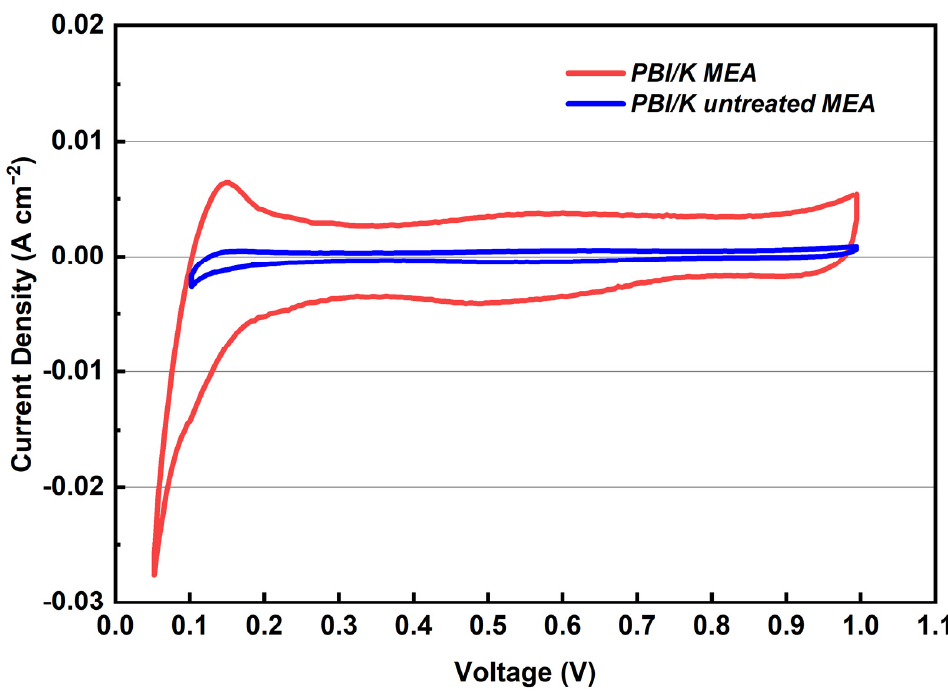
Figure 7. Cyclic voltammograms of treated and untreated PBI/K MEAs at 160 °C feeding with dry H 2 /N 2 (equal H 2 and N 2 flow rates at 0.4 L min − 1 ).